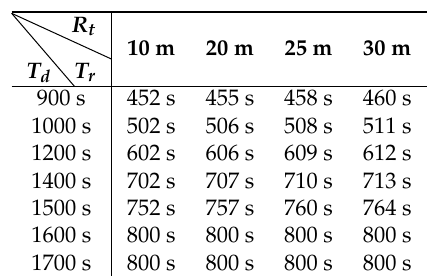
Table 5. The value of T r under different values of T d and R t